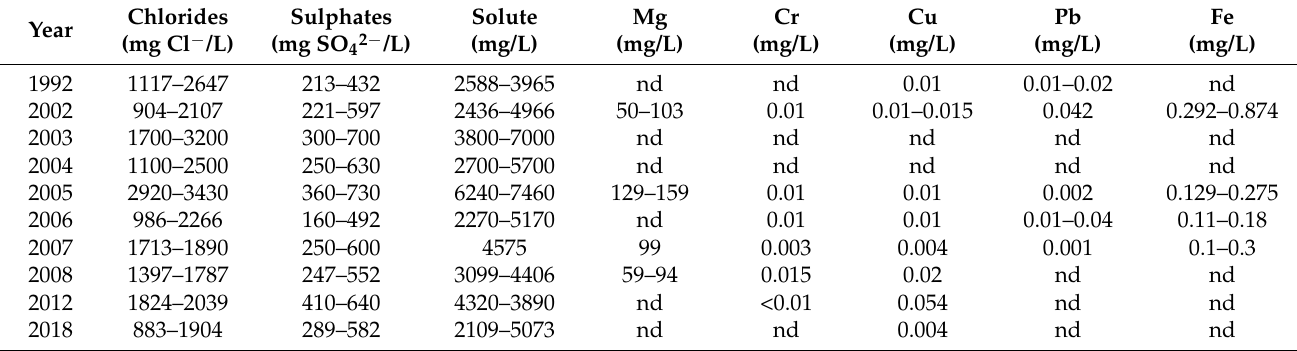
Table 2. Average values of selected pollution indicators in the Kłodnica river from 1992–2018, the ranges are based on several measurement points. Based on data from the Environmental Protection Inspection obtained by the State Environmental Monitoring.